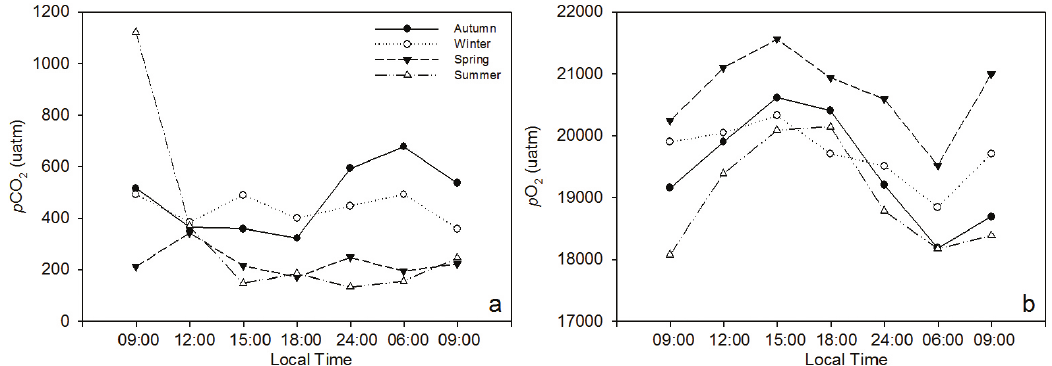
(a) and p O (b) in Peri Lake during the sampled period in autumn 2 2